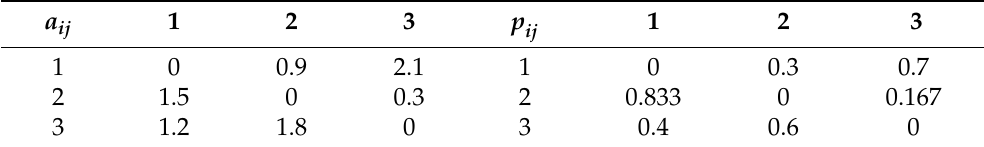
Table 1. Real values for the parameters a ij and transition probabilities p ij .